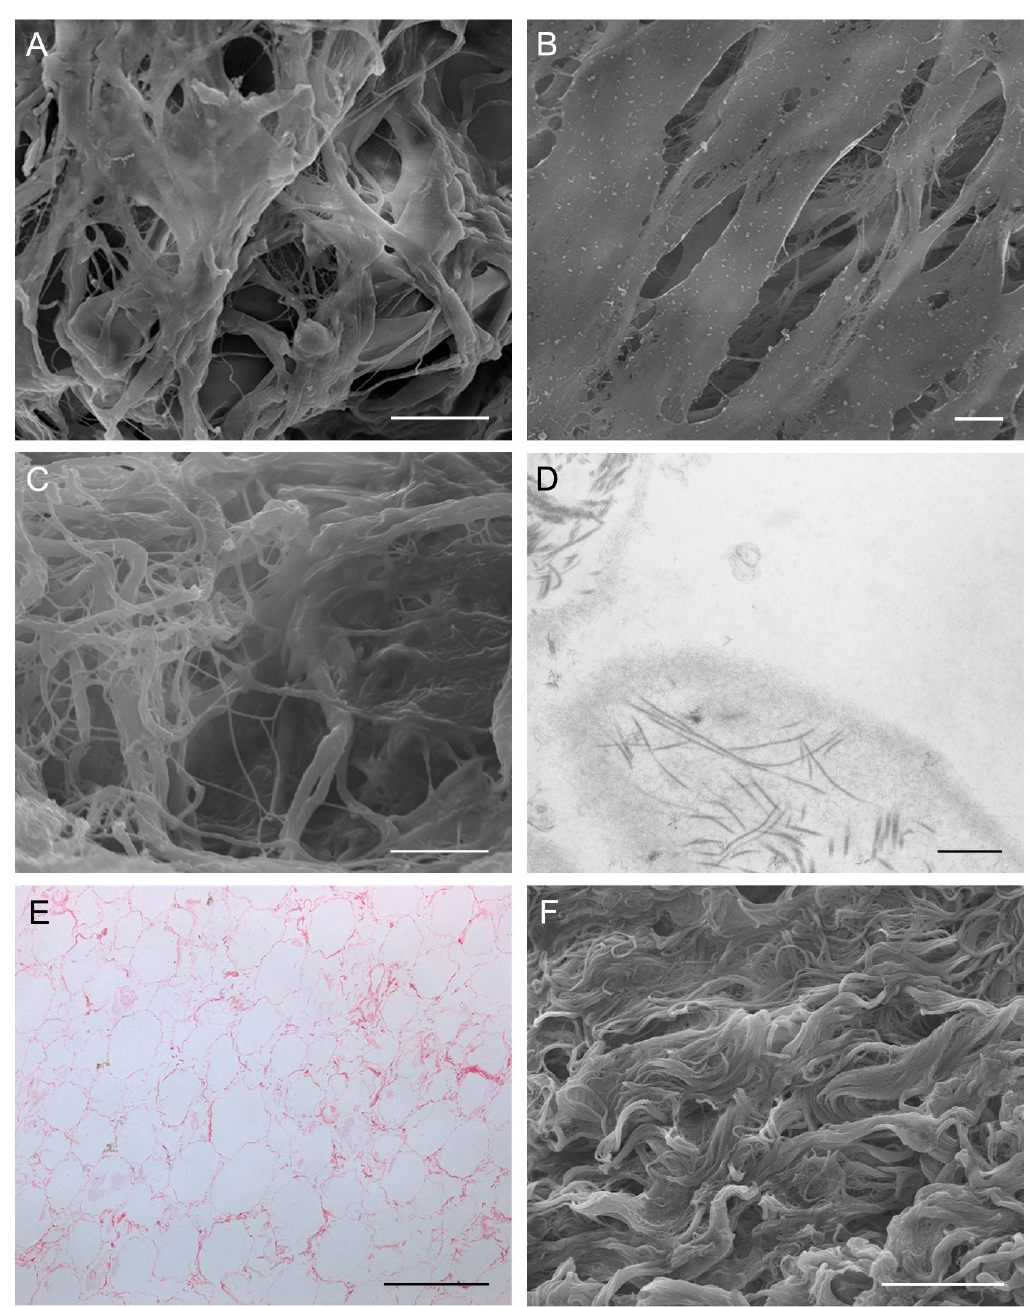
Figure 2. Decellularized human extracellular matrices. Ultrastuctural appearance: scanning electron microscope image of an articular cartilage scaffold before ( A ) and 14 days after primary human chondrocytes seeding ( B ). Human cartilage was decellularized, homogenated, and lyophilized according to the experience of our group. Scanning ( C ) and transmission ( D ) electron microscope micrographs of decellularized skeletal muscle. Hematoxylin/eosin staining ( E ) and scanning electron microscope ultrastructural analysis ( F ) of decellularized omentum. Scale bars: (A,F), 50 µm; (B,C), 10 µm; (D), 1 µm; (E), 100 µm.